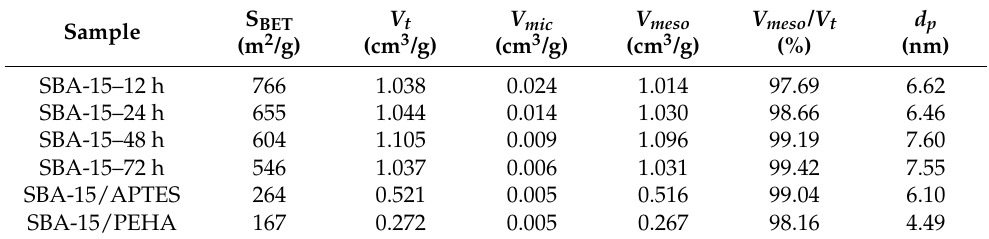
Table 1. Surface area, pore volume, and pore diameter of silica specimens.